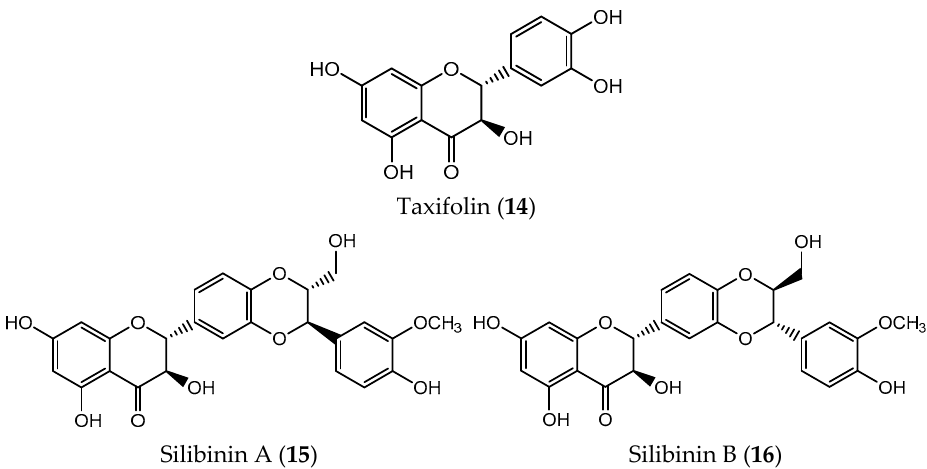
Figure 4. Chemical structures of flavonol taxifolin ( 14 ) and silibinin diastereoisomers ( 15 and 16 ). Daidzein ( 17 , Figure 5), also known as soy isoflavone, through intestinal metabolism form the enantiomer S -(-)-equol ( 18 ) [95]. Isoflavones show potential estrogenic and anti-